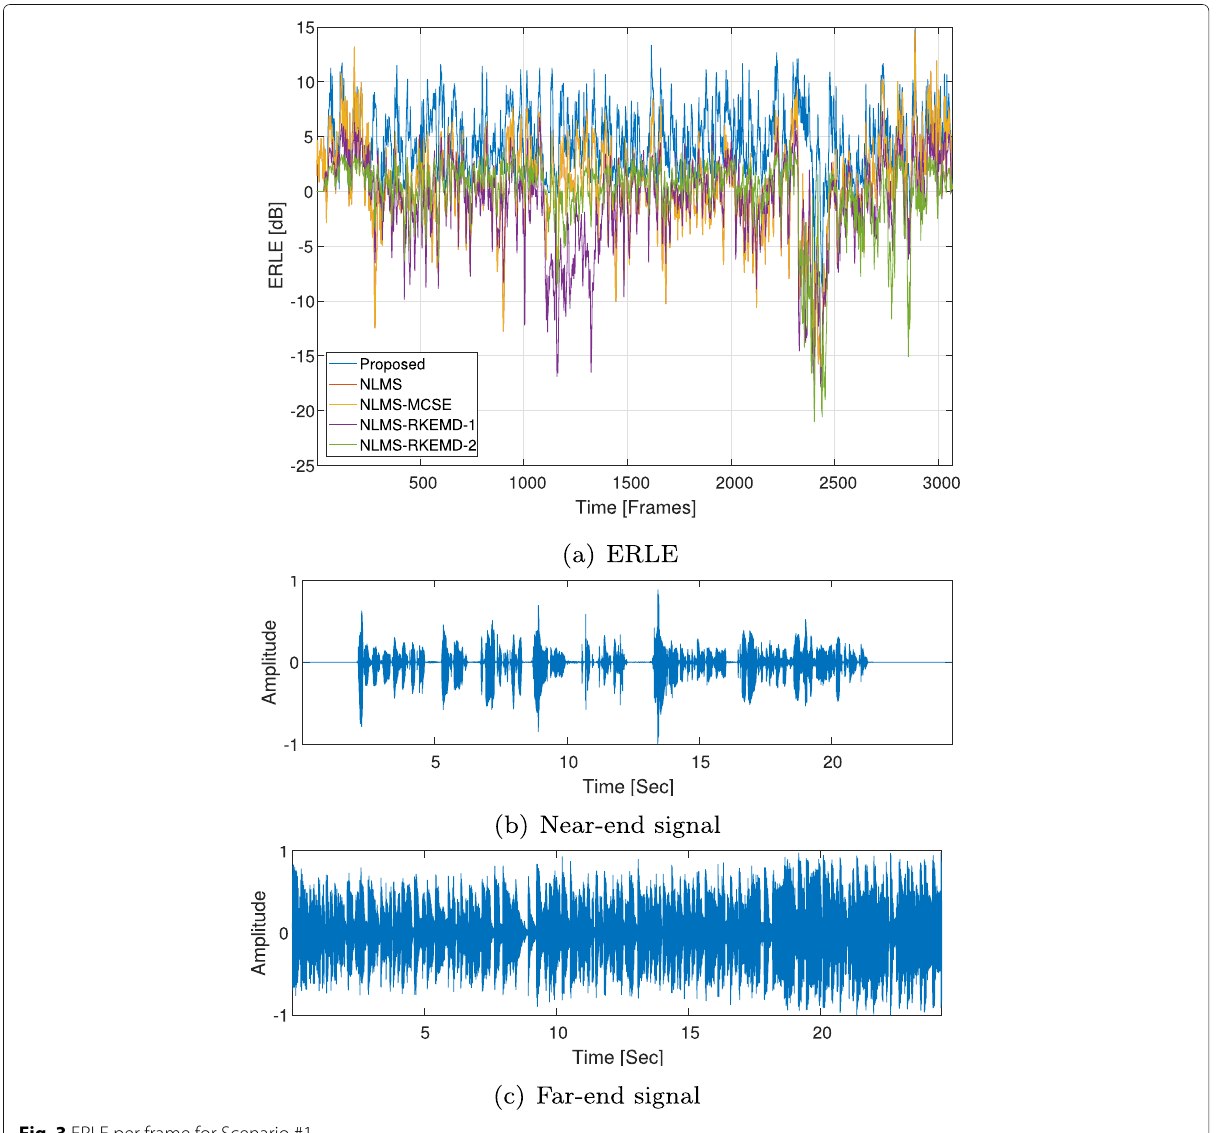
Fig. 3 ERLE per frame for Scenario #1